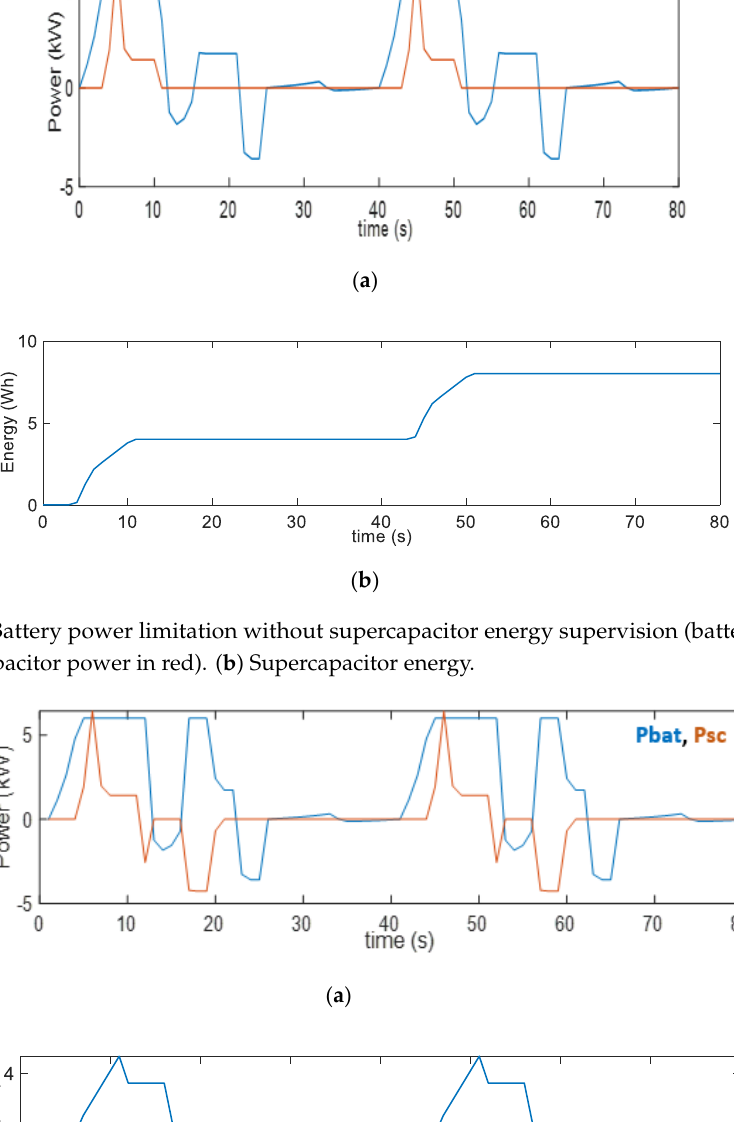
Figure 11. Weight results according to different power battery limits. Table 5. Results from energy management test (number of cells, capacity and volume). EB45AH/BCAP0350—VDI Cycle (7 h) Battery